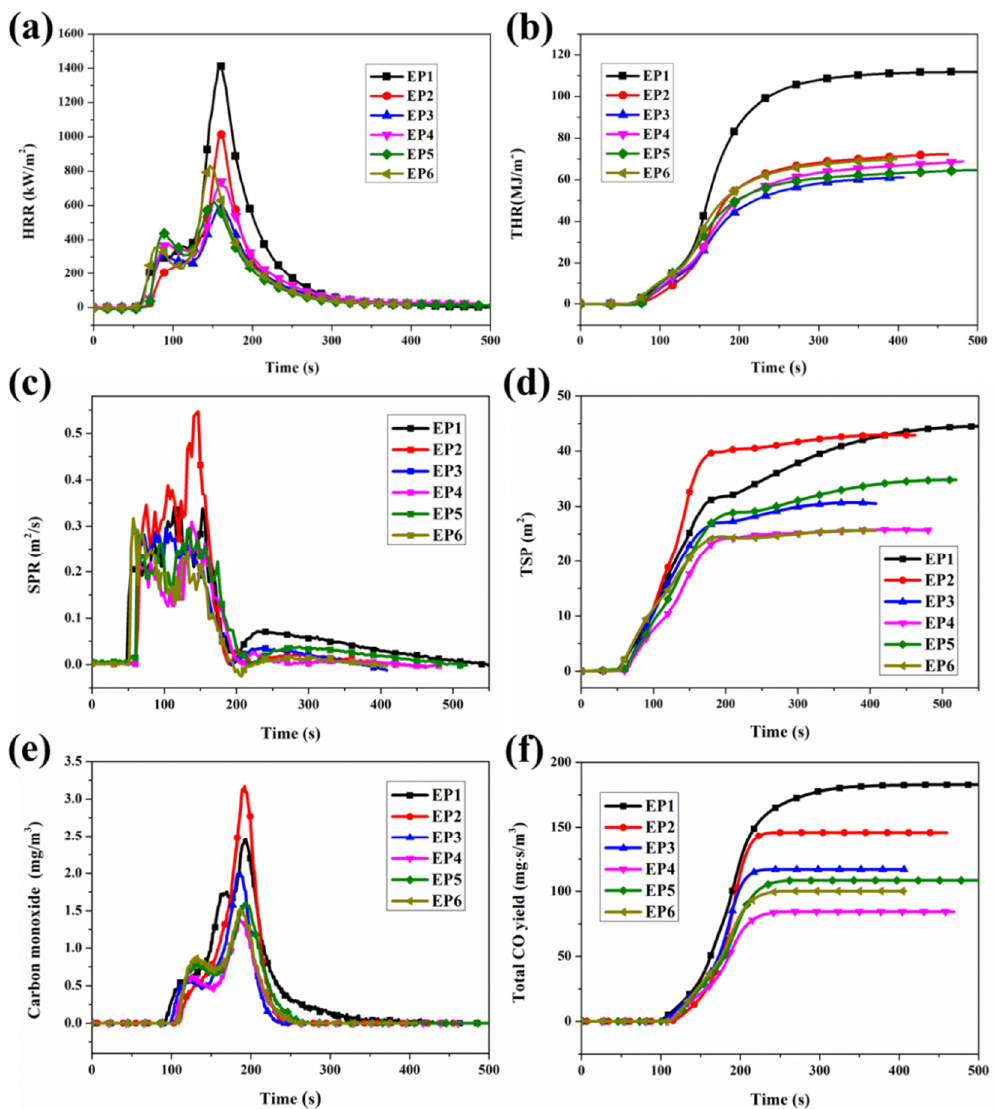
Figure 4. Heat release rate ( a ), total heat release ( b ) smoke production rate (SPR) ( c ), total smoke production (TSP) ( d ), CO ( e ), and total CO yield ( f ) versus temperature curves of pristine EP and its composites from cone test.